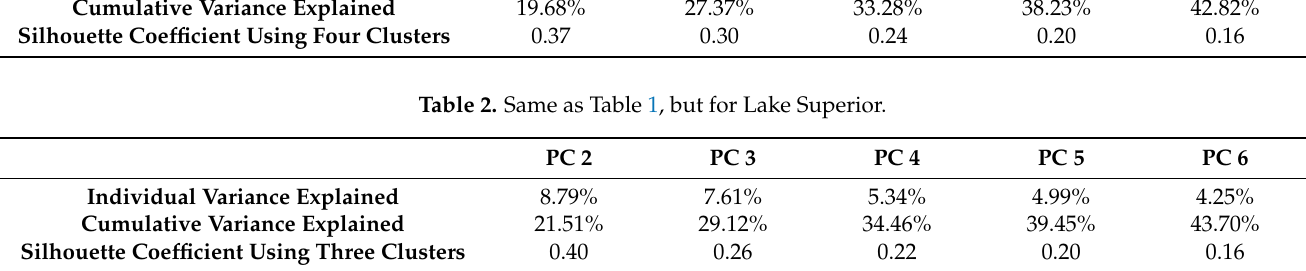
Figure 5. Seasonal distribution of LES cases among different clusters for Lake Michigan ( top ) and Lake Superior ( bottom ).